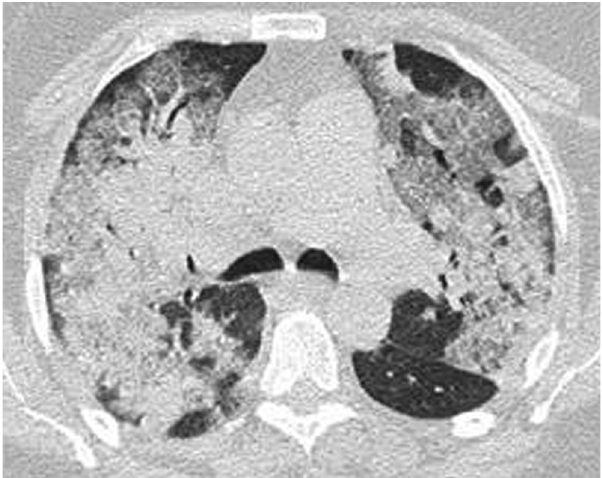
Figure 1 – X-ray computed tomography of the thorax showing diffuse, patchy bilateral ground glass opacities and consolidation at ICU